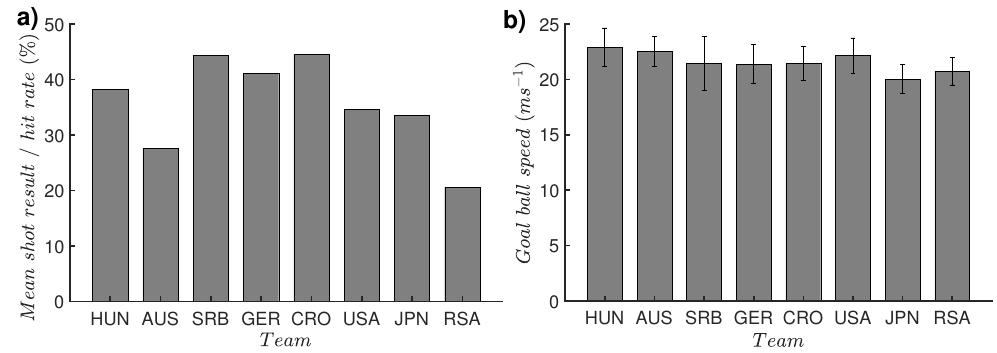
Figure 7. ( a ) Hit rates of the eight nations participating in the 2018 World Cup Final (in order of tournament placement). ( b ) Team comparison of ball speed (at time t3, leaving hand; F 7;185 = 7.00; p < 0.001) during goal completion with drive